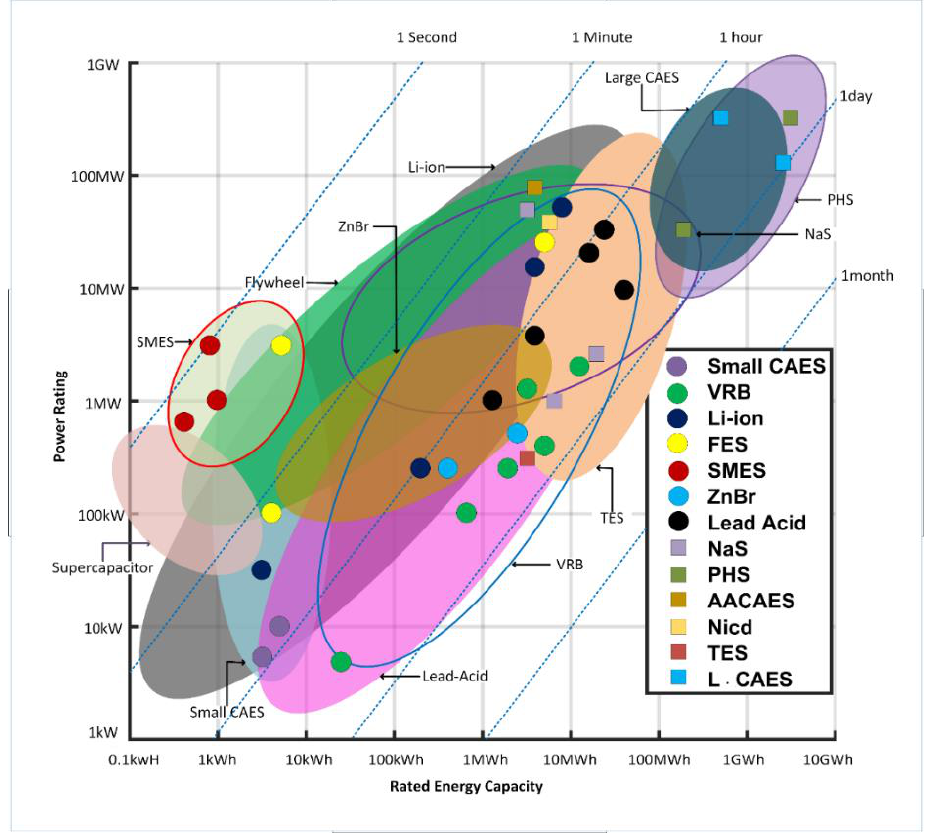
Figure 78. Comparison of power rating and rated energy capacity with discharge time duration at power rating of di ff erent types of ESSs [26].